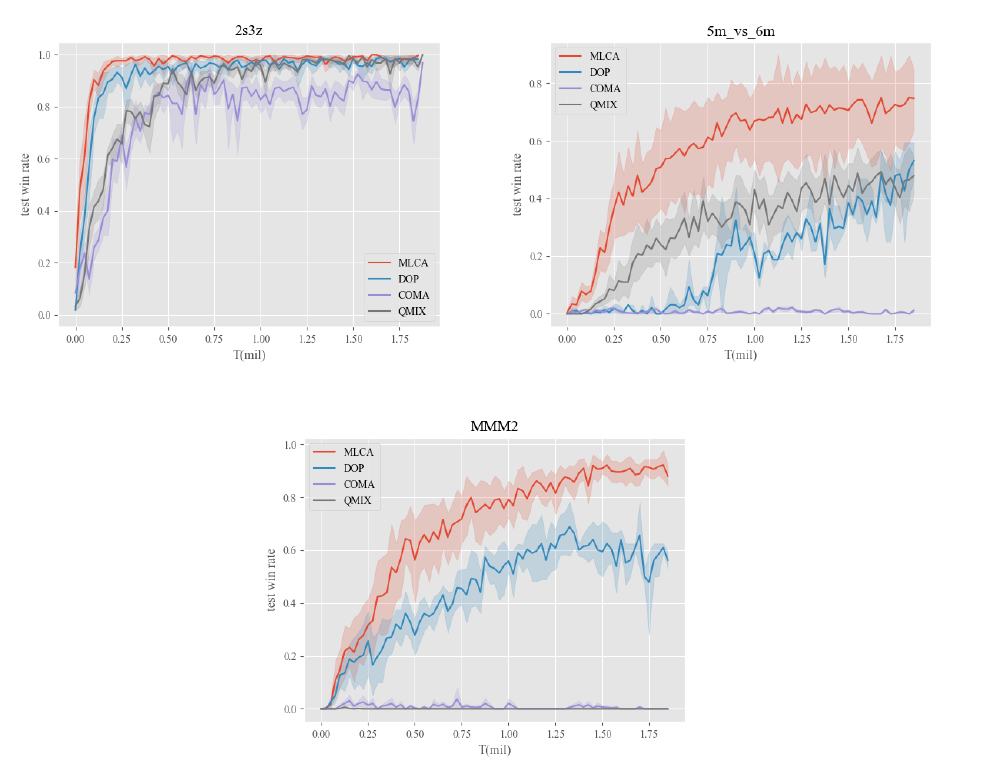
Figure 4. Comparing performance across various scenarios in SMAC. DOP, COMA and QMIX serve as the baseline methods and MLCA is the proposed